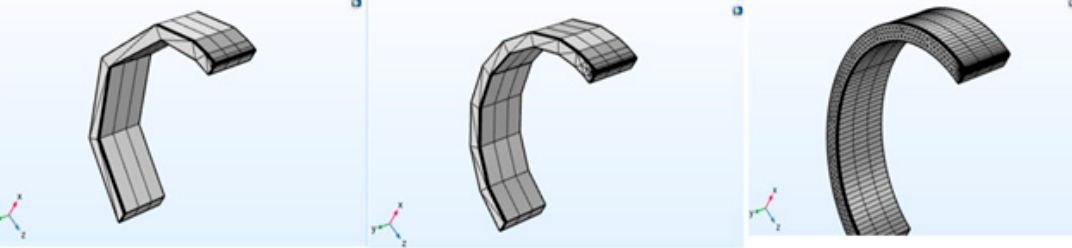
Figure 9. Model of pipe indicating the integration contours for J-integral evaluation.